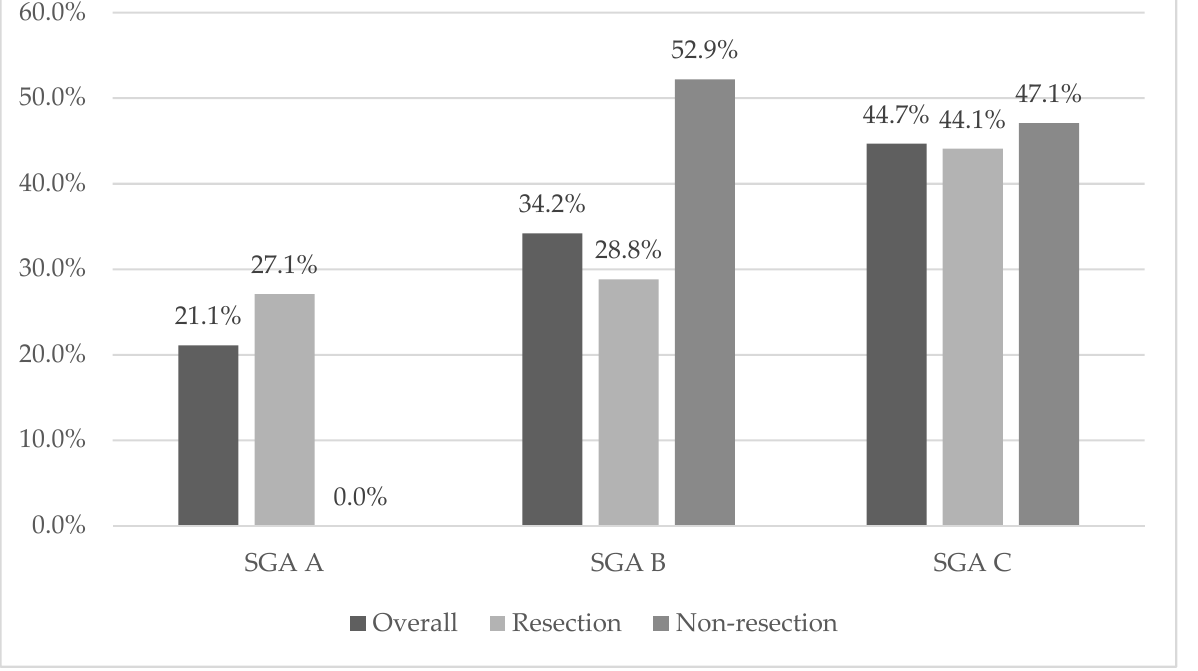
Figure 2. Distribution of the severity of malnutrition based on SGA compared with overall, resection and non-resection: SGA A: well nourished, SGA B: moderately malnourished or at risk of malnutrition, SGA C: severely malnourished.